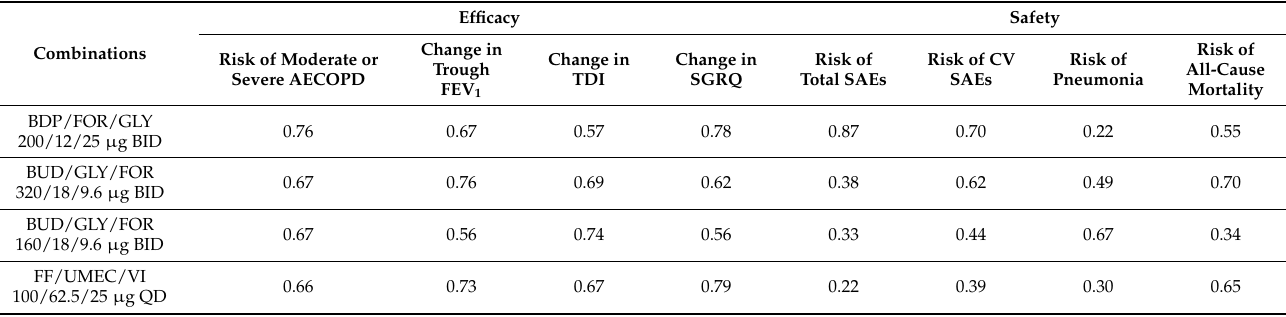
Table 3. SUCRA § values for efficacy and safety of triple FDCs according to the sensitivity analysis performed on the Bayesian